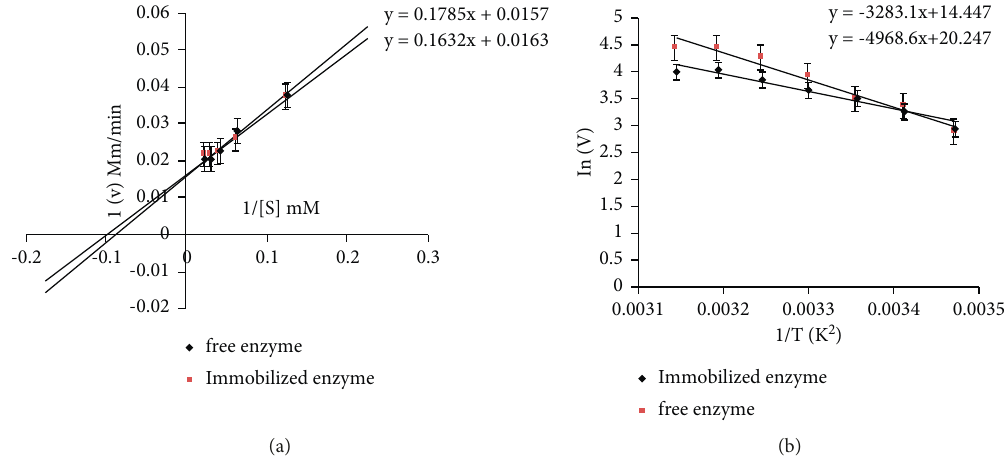
Figure 2: (a) Lineweaver–Burk plots of free enzyme and immobilized enzyme and (b) Arrhenius relationships of free enzyme and immobilized enzyme.